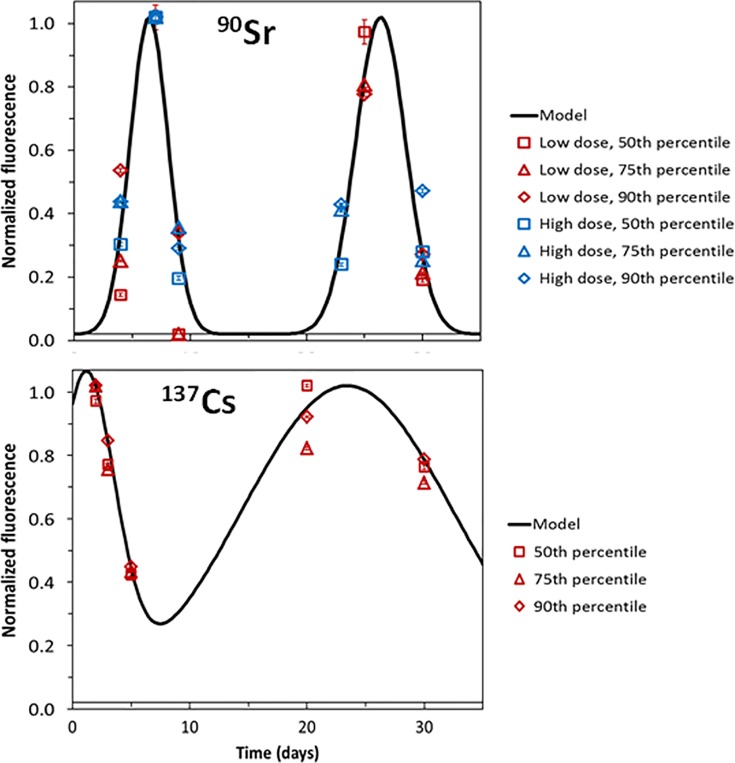
Temporal kinetics of γ-H2AX fluorescence after single administration of high and low dose 90Sr, and 137Cs.Error bars represent standard deviations.